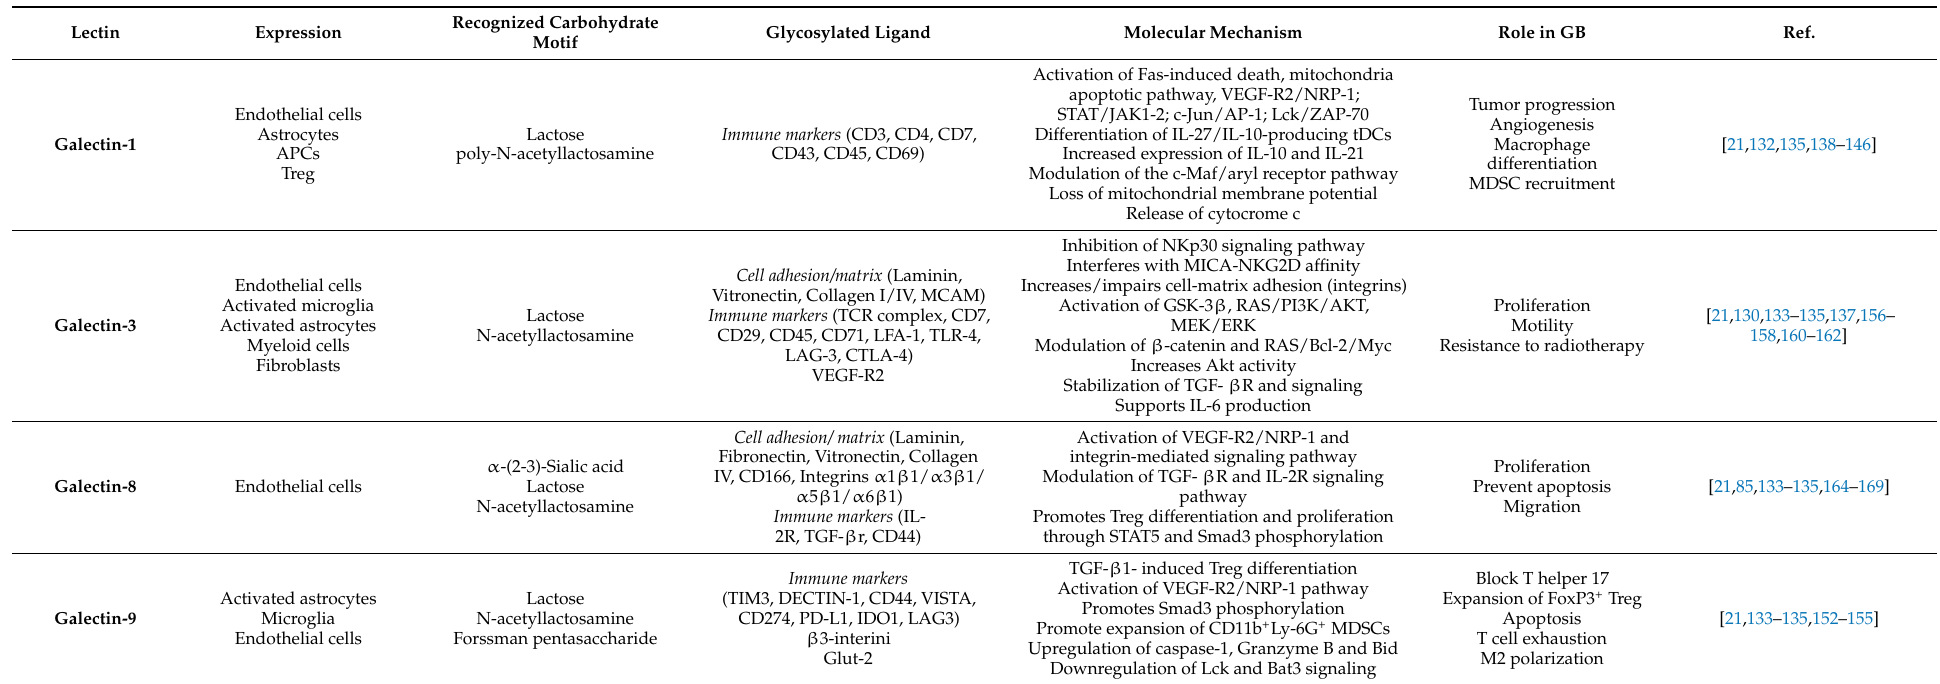
Table 2. Classification, expression, binding preference, glycosylated ligand, known molecular mechanisms and role of galectins in GB. Abbreviations: N- acetyllactosamine: LacNAc; Gal β 1-4GlcNAc; Forssman pentasaccharide: GalNAc- α -(1,3)-GalNAc- β -(1,3)-Gal- α -(1,4)-Gal- β -(1,4)-Glc; MCAM: Melanoma